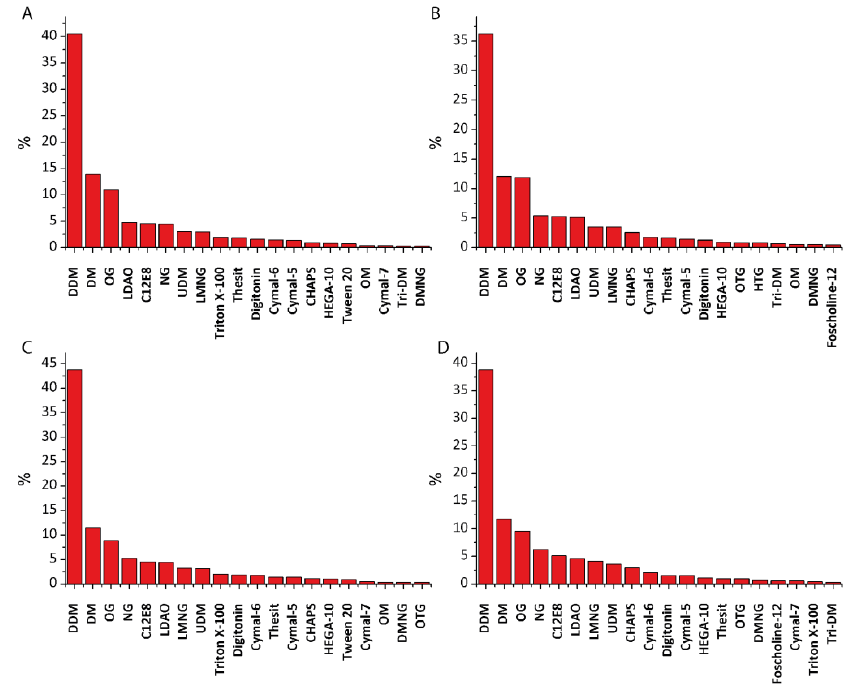
Figure 2. The bar representation (in %) of different detergents used for ( A ) purification and ( B ) crystallization. Panels ( C ) and ( D ) include data only for the time period of 2006–2016.